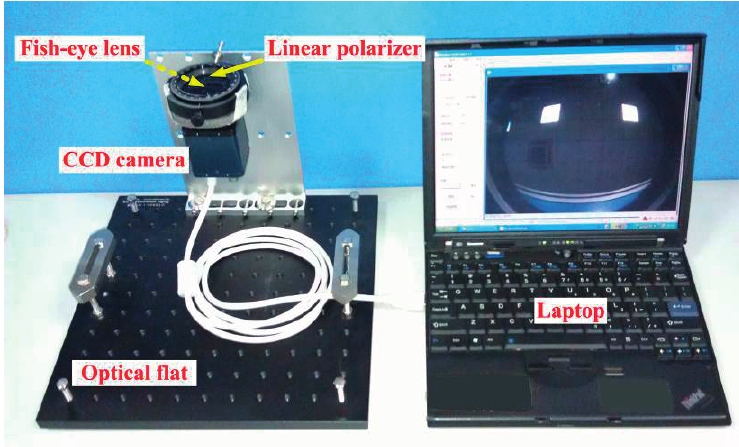
Figure 1. Full-sky imaging polarimetry